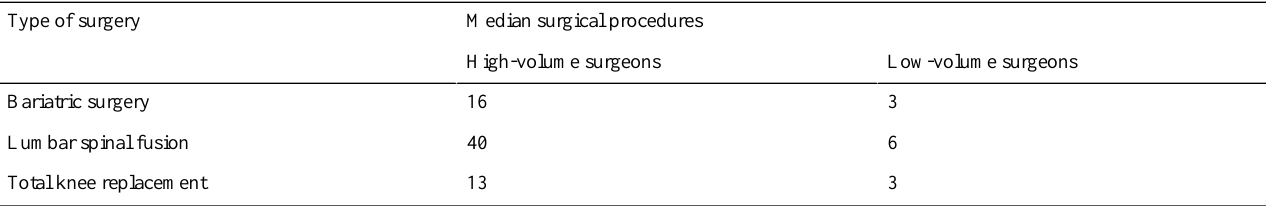
Table 3. Median number of surgical procedures performed by high- and low-volume surgeons a .